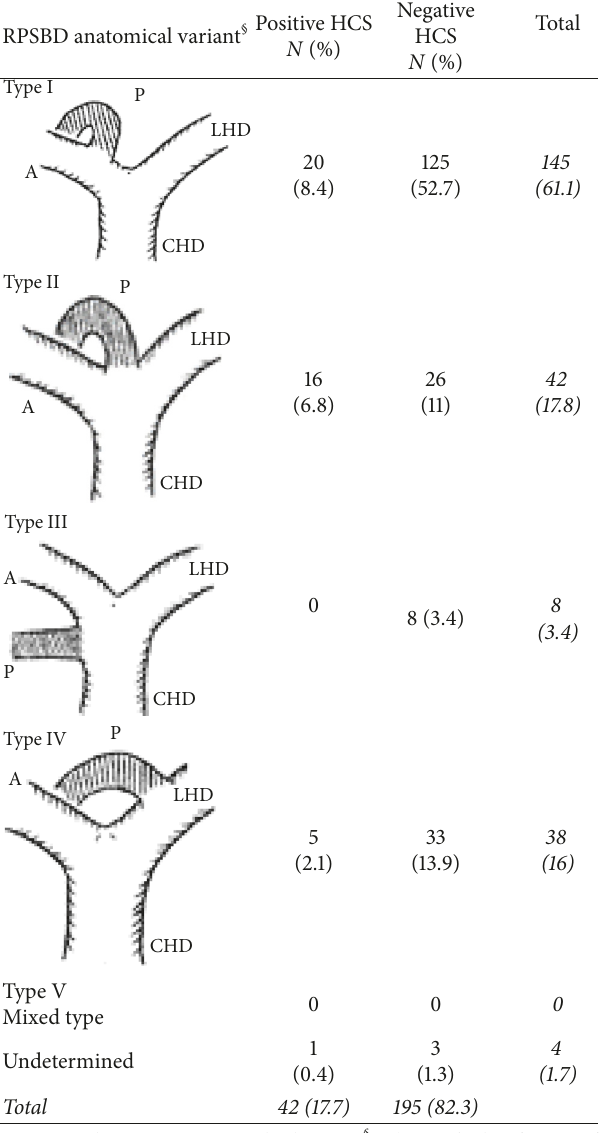
Table 3: Comparative evaluation of different types of Hjortsjo Crook Sign.